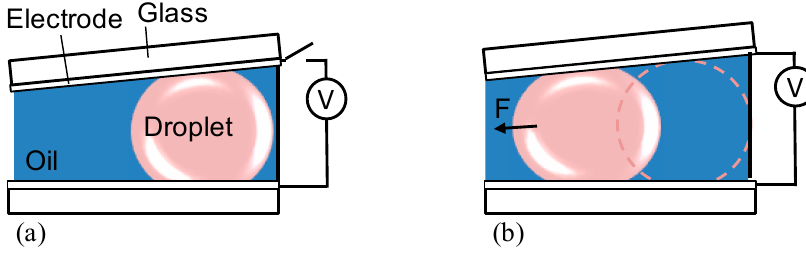
Figure 1. Cross-sectional structure of the cell in ( a ) relaxing state and ( b ) actuating state. To depict the moving mechanism of the droplet in the actuating state, a cross-sectional structure with defined parameters is given in Figure 2. The droplet has four contact angles on the substrate surfaces.